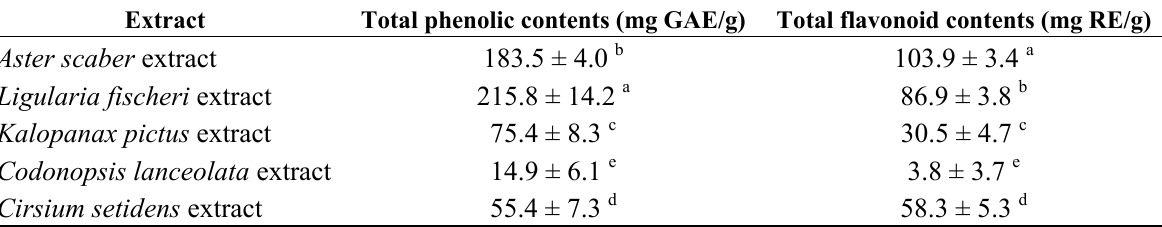
Table 1. Total phenolic and flavonoid contents of methanol extracts of five wild herbs.